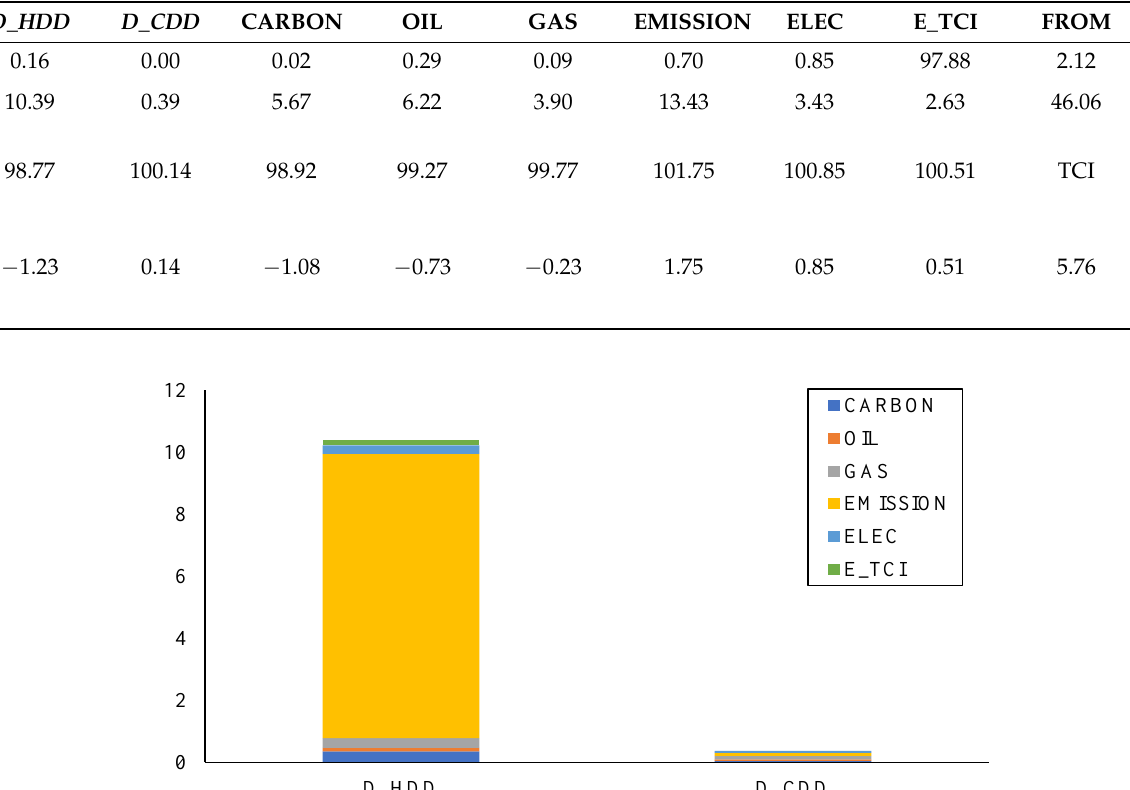
Figure 7. Spillover effects from D_HDD and D_CDD to other indicators.